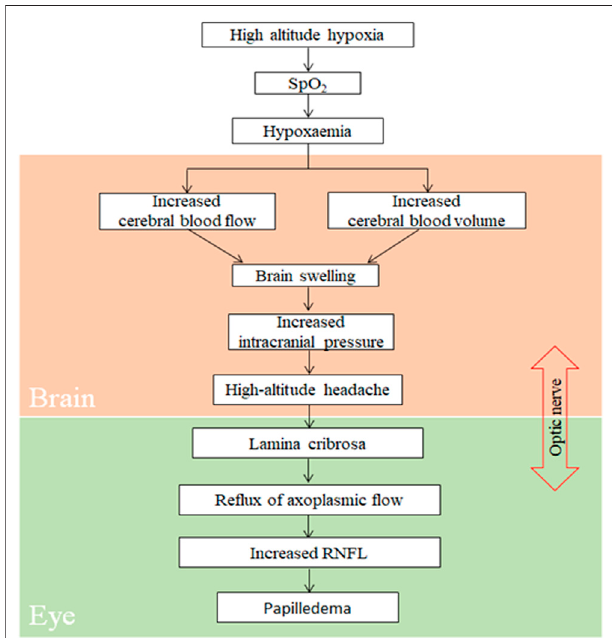
FIGURE 5 | Proposed pathophysiology of retinal nerve fi ber layer during exposure to high altitude. Spo2, oxygen saturation; RNFL, retinal nerve fi ber